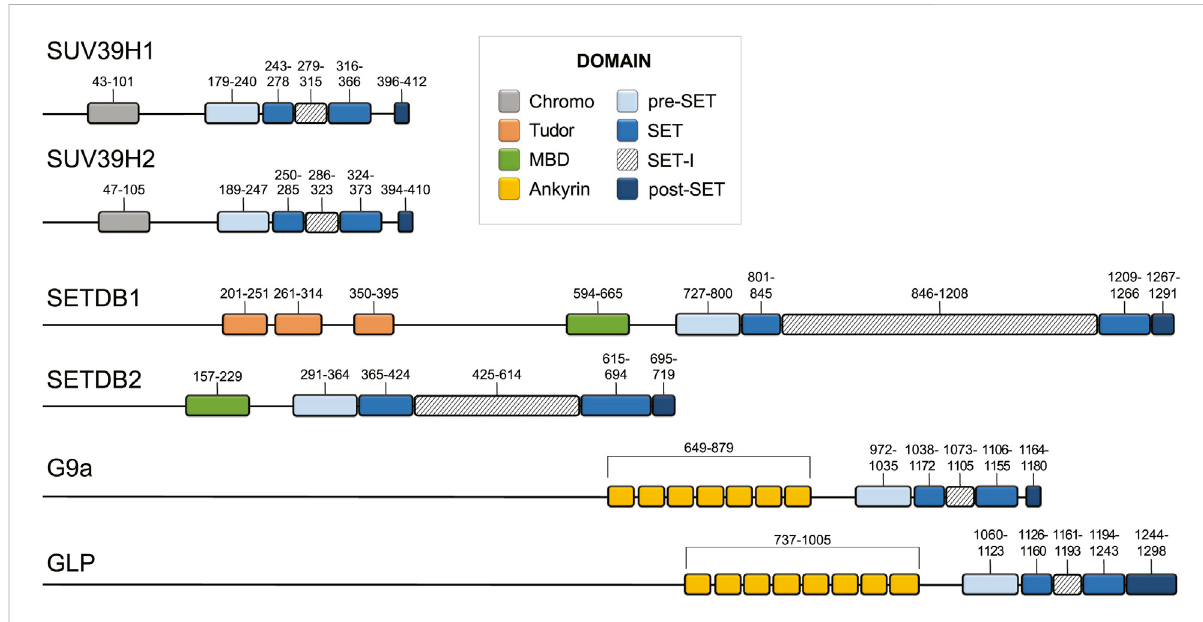
FIGURE 2 Domain architecture of the main human H3K9 methyltransferases. Domain architecture of SUV39H1, SUV39H2, SETDB1, SETDB2, G9a, and GLP (Apweiler et al., 2004; Wu et al., 2010; Torrano et al., 2019; Weirich et al., 2021). Domain boundaries are listed above each domain with chromodomain, pre-SET, SET, SET-I, post-SET, Tudor, MBD, and Ankyrin repeat domains coloured grey, light blue, blue, diagonal hatching, dark blue, orange, green, and yellow, respectively.